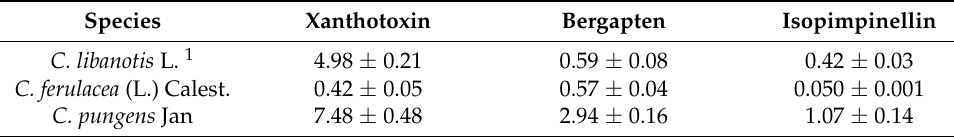
Table 2. Quantitative analysis of identified furanocoumarins.